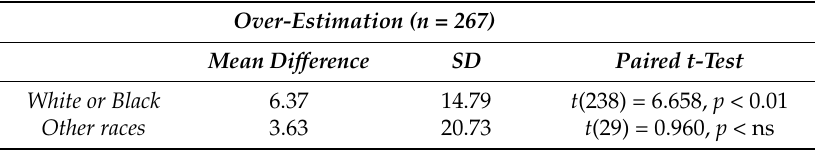
Table 3. Paired t -tests on over-estimation of Indigenous American heritage.